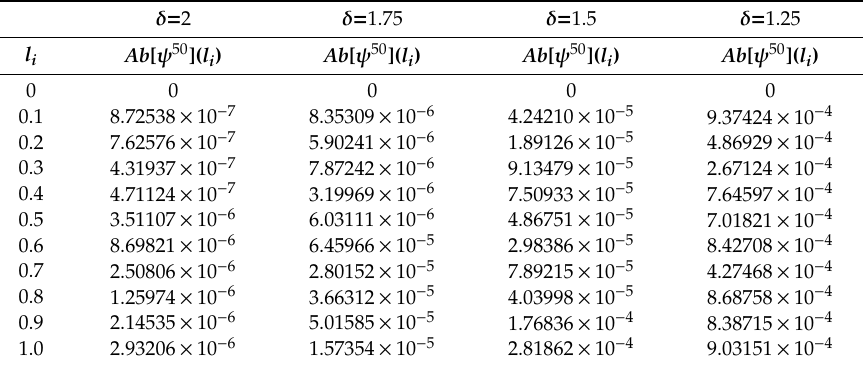
Table 3. Numerical results of Example 3 using